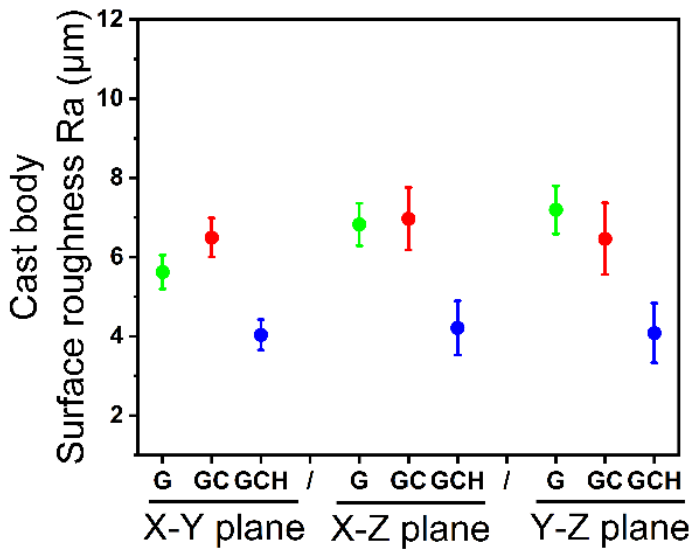
Figure 8. Surface roughness of X-Y, X-Z, Y-Z surfaces of a box-shaped 10 mm thick mold by process.